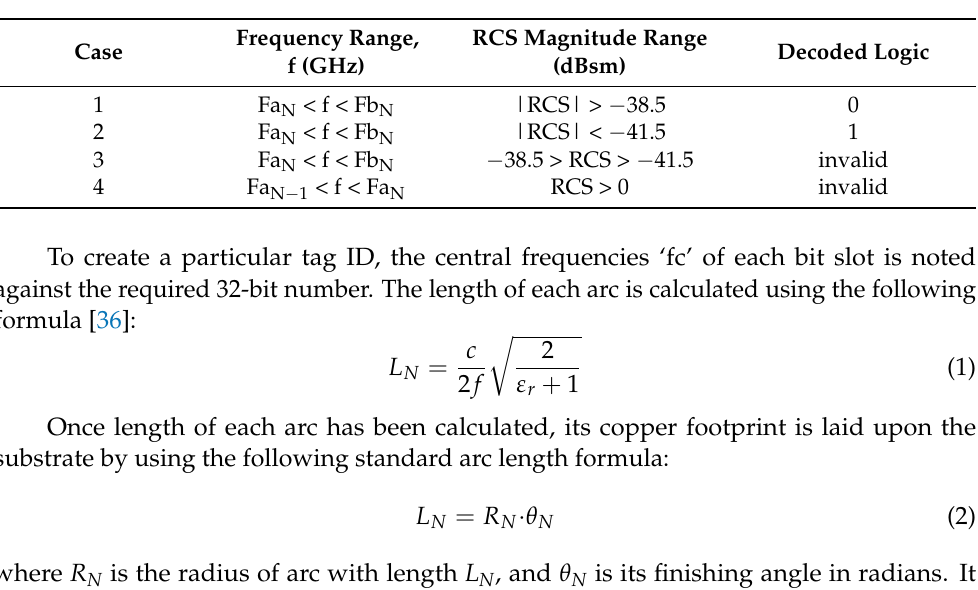
Table 1. Summary of bit decoding process.